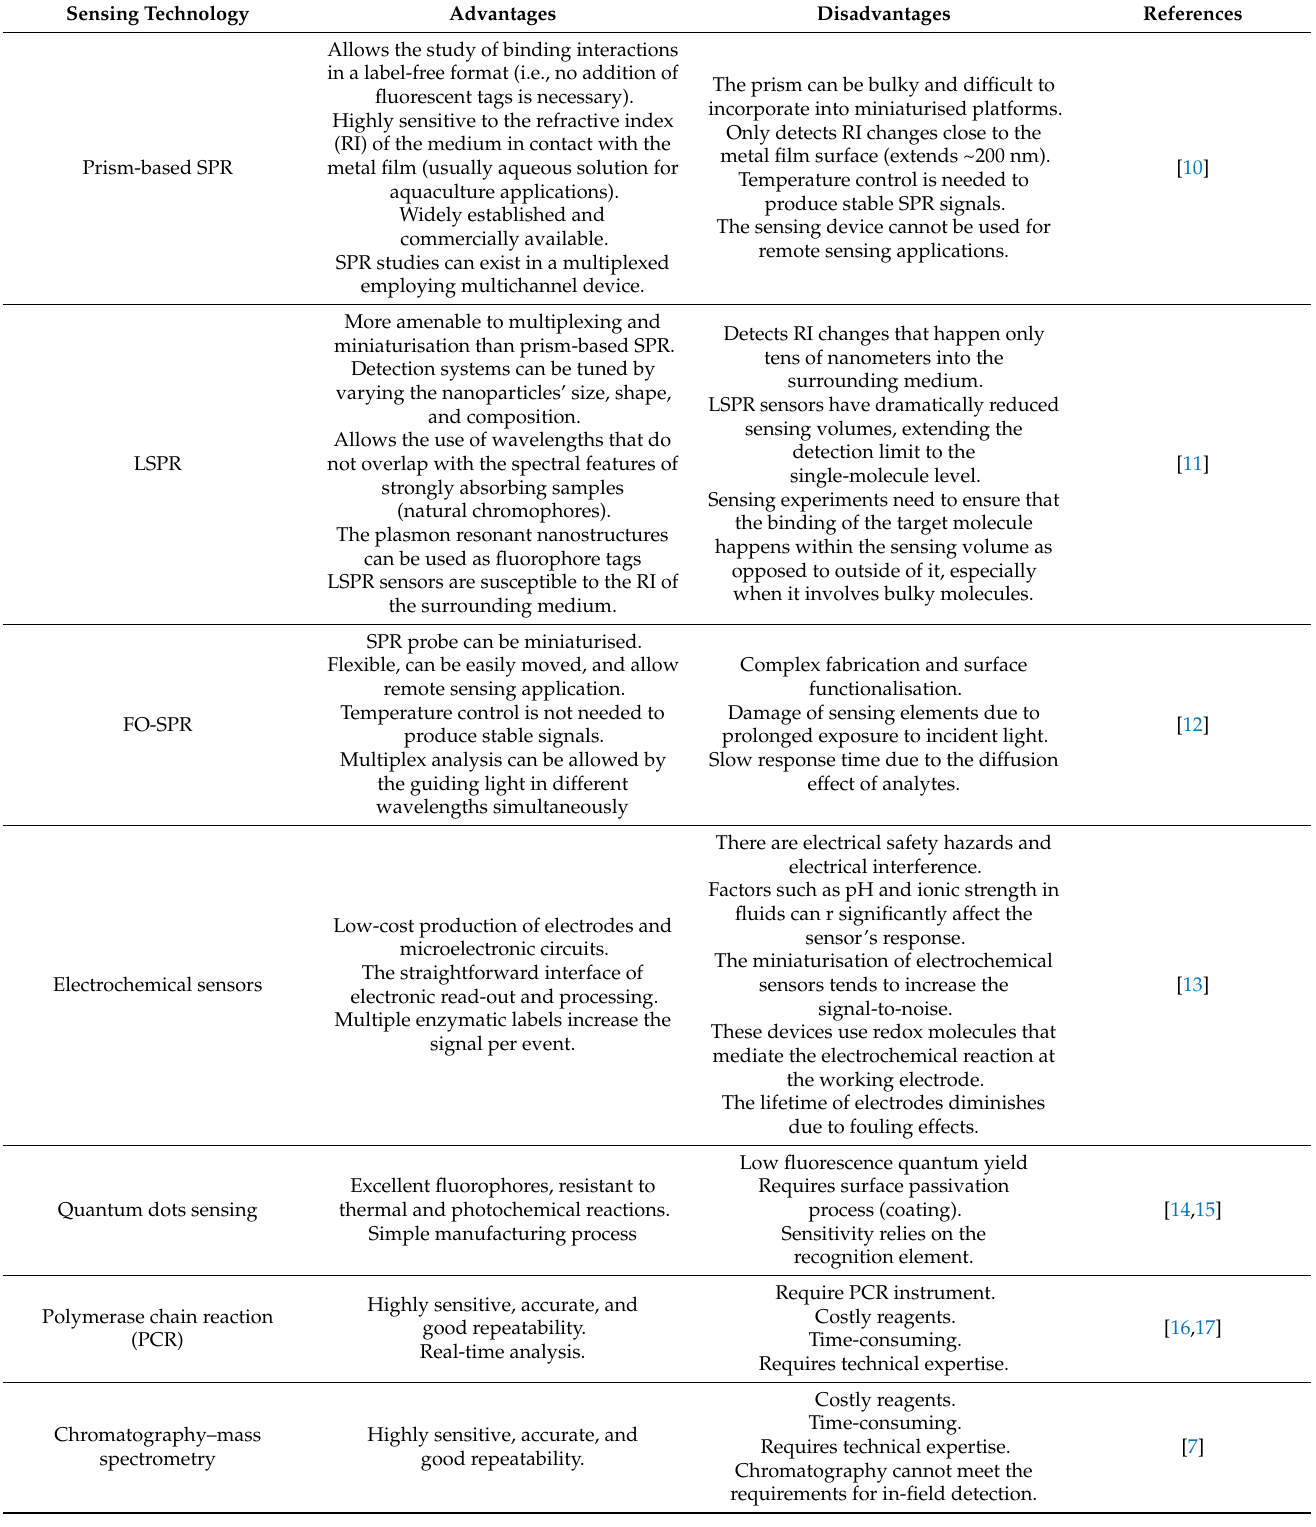
Table 1. Comparison of latest sensing technologies used in